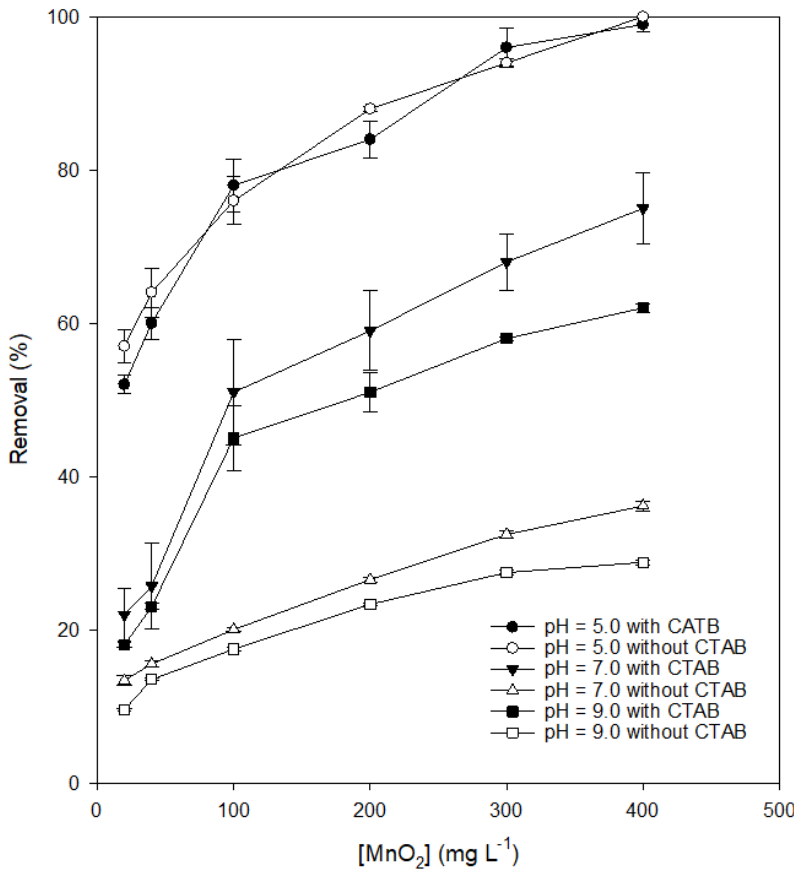
Figure 3. Effect of the dosage of MnO 2 on the removal of diclofenac (DIC) in the presence and absence of cetyltrimethyl-ammonium bromide (CTAB). (Reaction time = 1 day, initial DIC conc. = 100 µM, surfactant conc. = 100 µM, T = 25 °C).